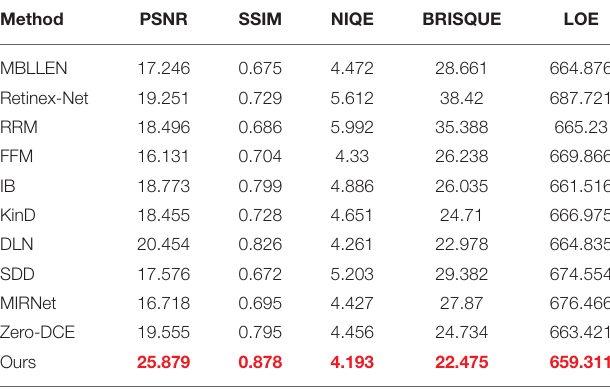
The best results are marked in bold red.